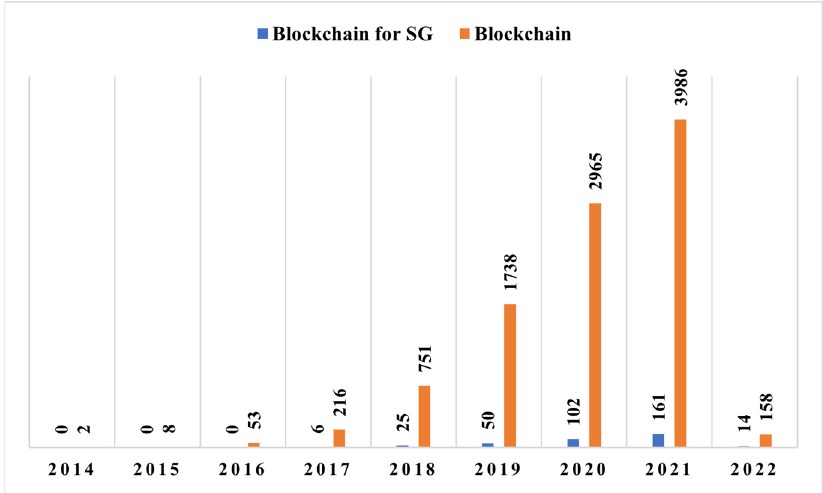
Figure 2. Number of articles on blockchain and blockchain in smart grids. Table 1. A summarized survey of some review papers related to smart grid application.